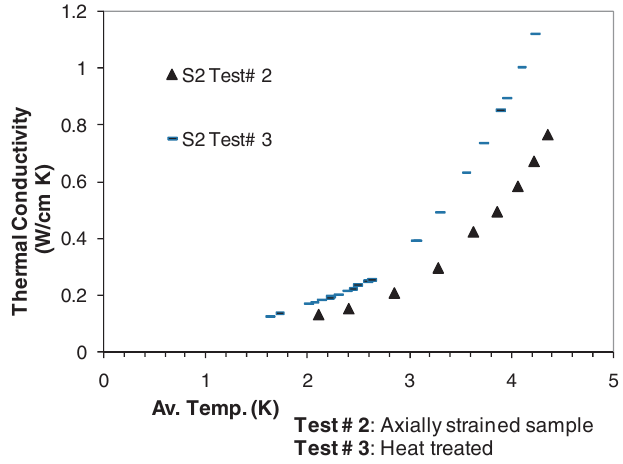
FIG. 8. (Color) The phonon peak did not reappear after it was lost during the compression process in preparation of (test #2) sample S2. The low temperature heat treatment (test #3) has a small effect on the thermal conductivity of the